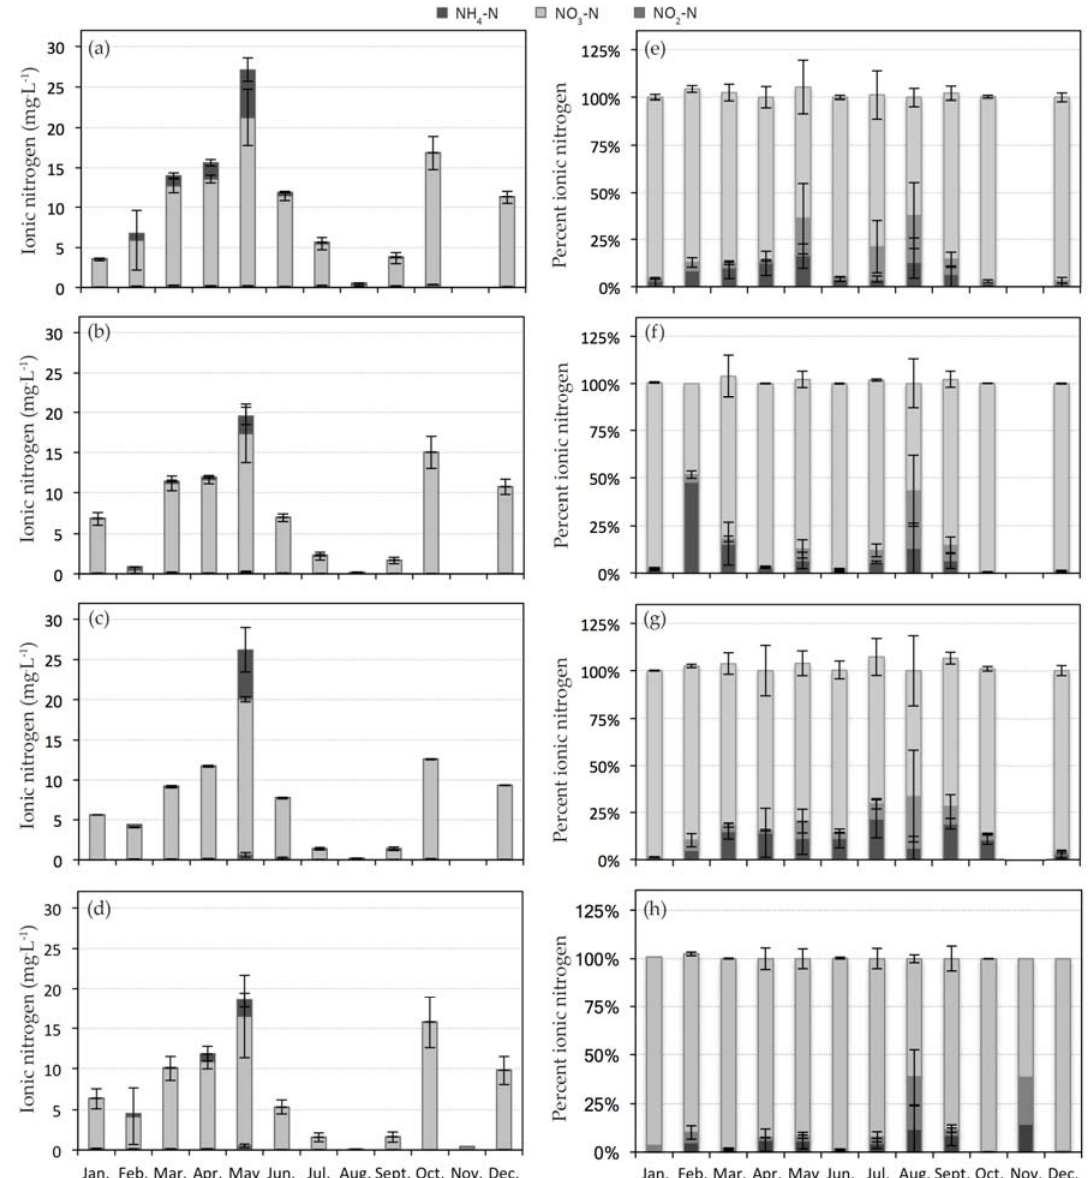
Figure 7. The concentration and percent of ionic nitrogen [nitrite (NO 2 -N), nitrate (NO 3 -N) and ammonium (NH 4 + -N)] detected in sites within Constructed Wetland 2 (CW2): ( a , e ) Site 2 (outflow from Stage 1); ( b , f ) Site 3 (outflow from Stage 2); ( c , g ) Site 4 (outflow from Stage 3); and ( d , h ) Site 5 (stilling pond). Error bars represent the standard error ( ± ) of the mean value.